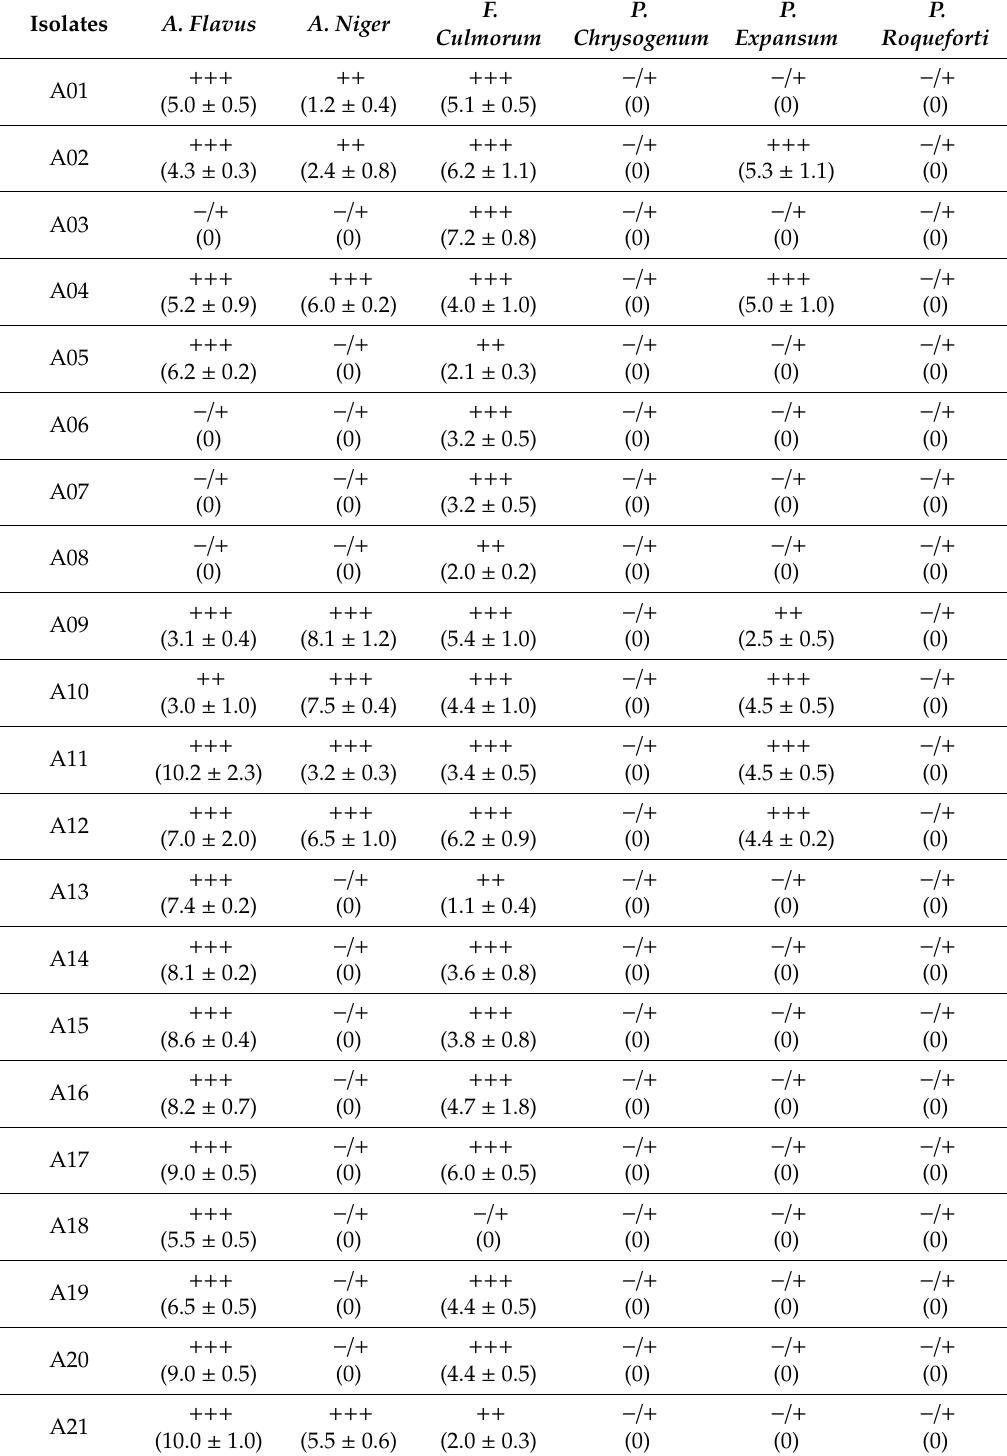
Table 5. Antifungal activity of the bacterial isolates against Aspergillus flavus , Aspergillus niger , Fusarium culmorum , Penicillium chrysogenum , Penicillium expansum , and Penicillium roqueforti .